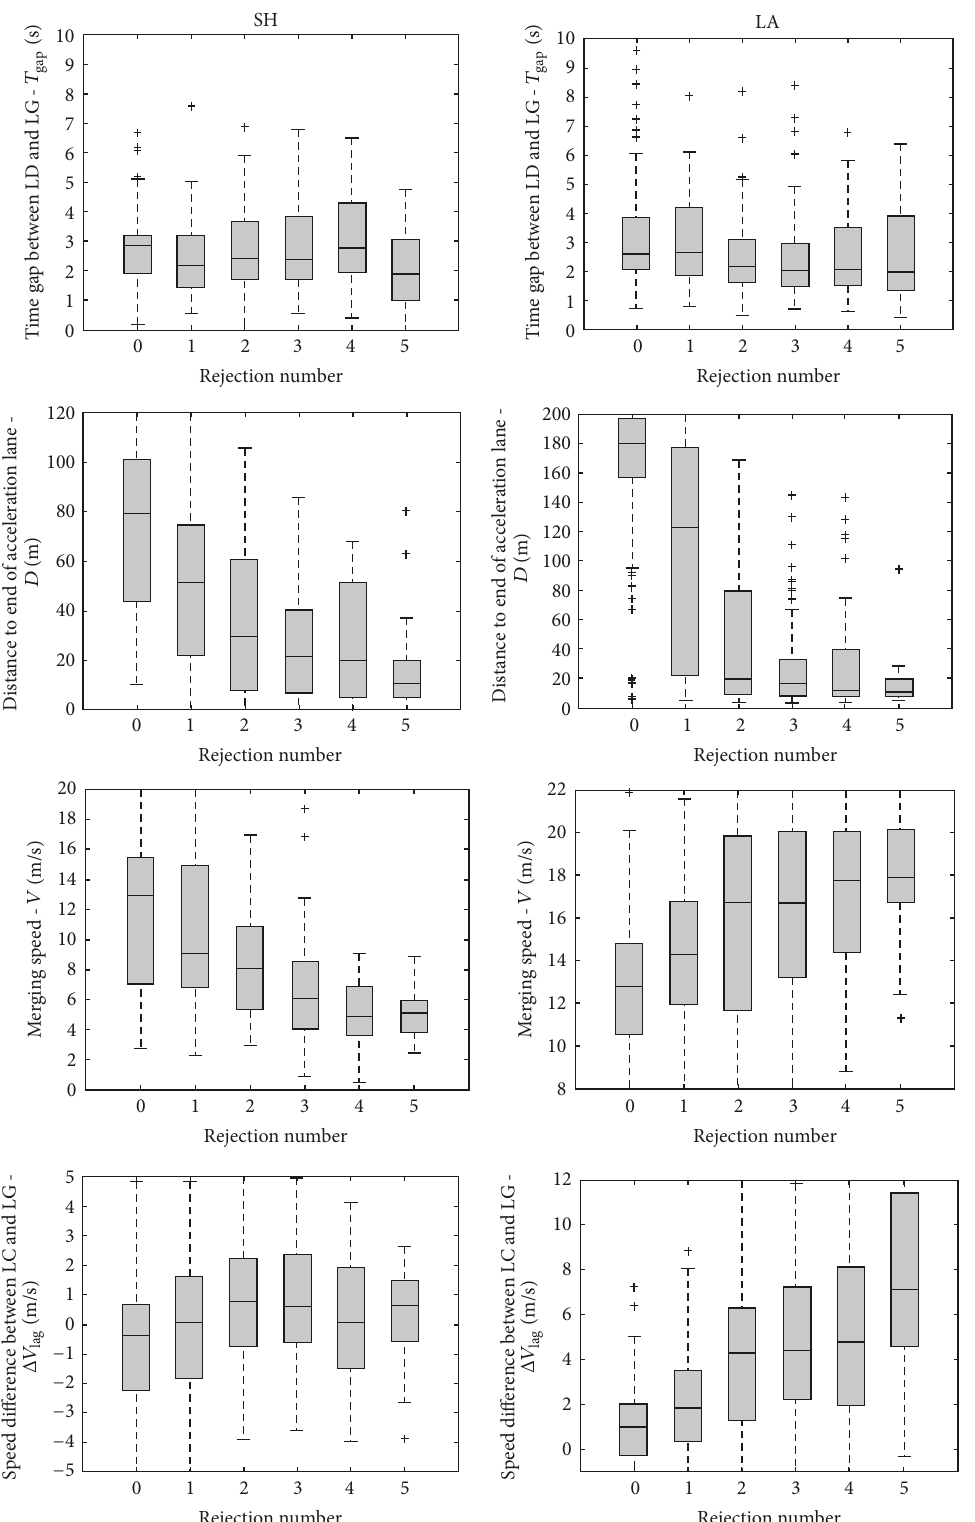
Figure 7: Merging features for various rejection numbers (the upper, middle, and lower lines of the box represent the 25th, 50th, and 75th percentiles of the data,